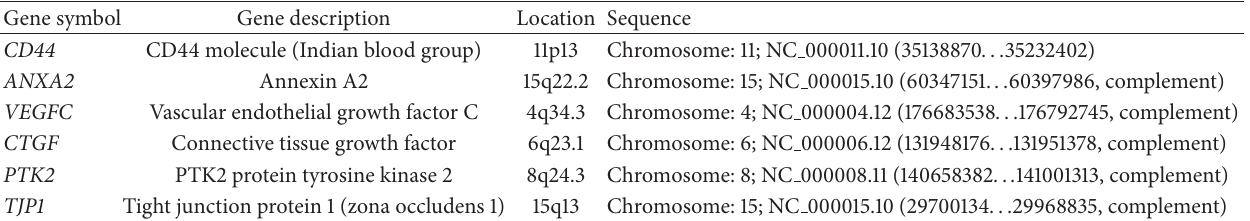
Table 2: Six hub genes identified by gene regulatory network